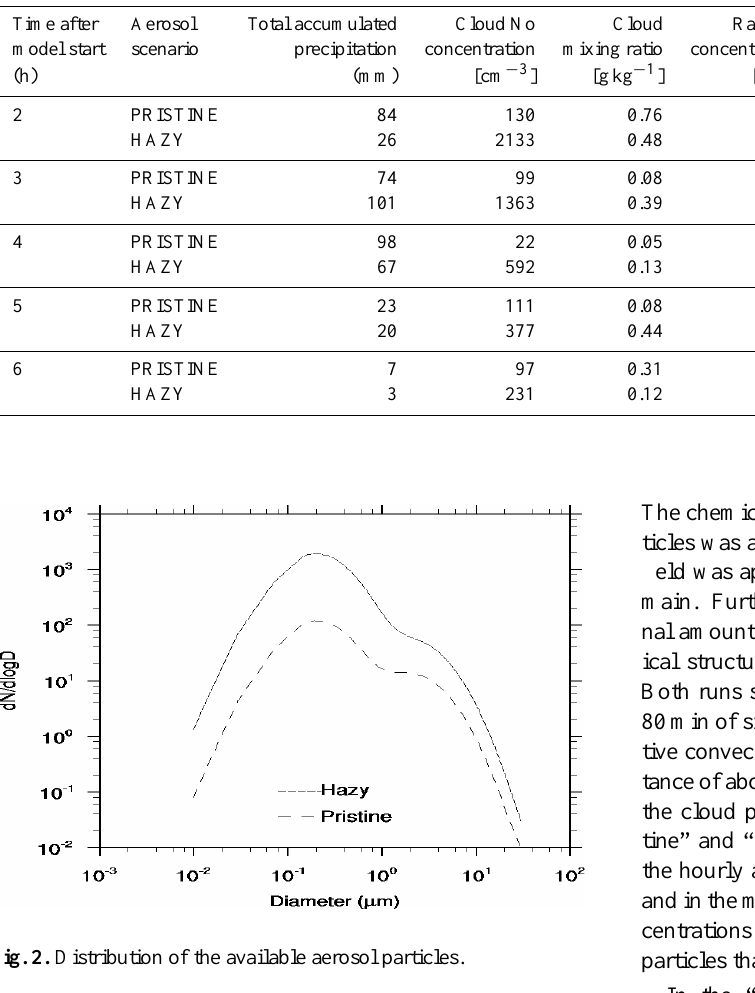
Table 2. Hourly accumulated precipitation over all the domain and maximum values for the number concentration and mixing ratio of cloud, rain and pristine-ice condensates, for two air mass type scenarios.